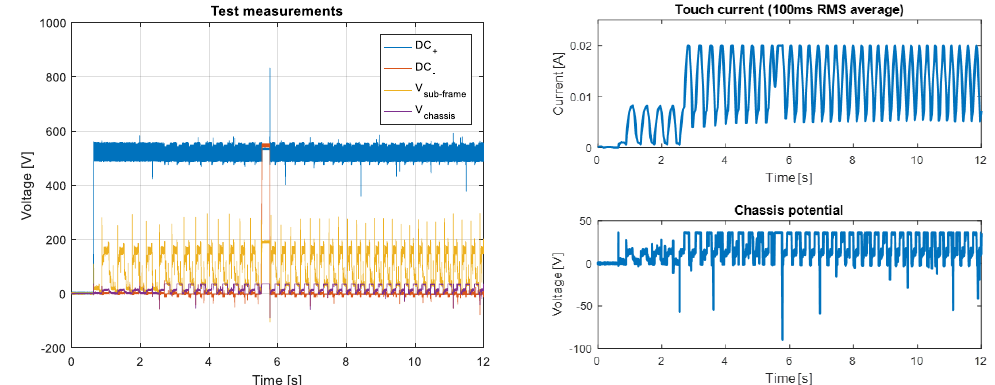
Figure 11. Measured voltages referred to earth (left), touch current RMS value over 100 ms ( right , top ), and chassis potential ( right , bottom ) under a pick-up-to-chassis insulation fault.